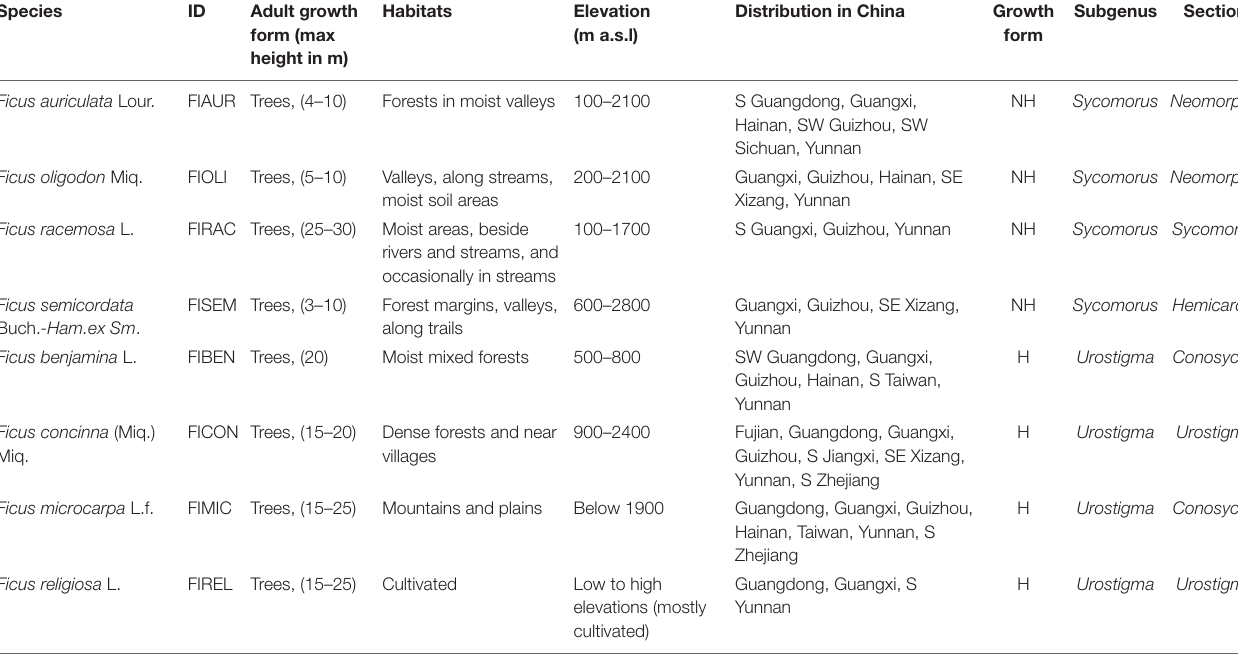
TABLE 1 | Characteristics of four hemiepiphytic (H) and four non-hemiepiphytic (NH) Ficus species investigated in this study*. Species